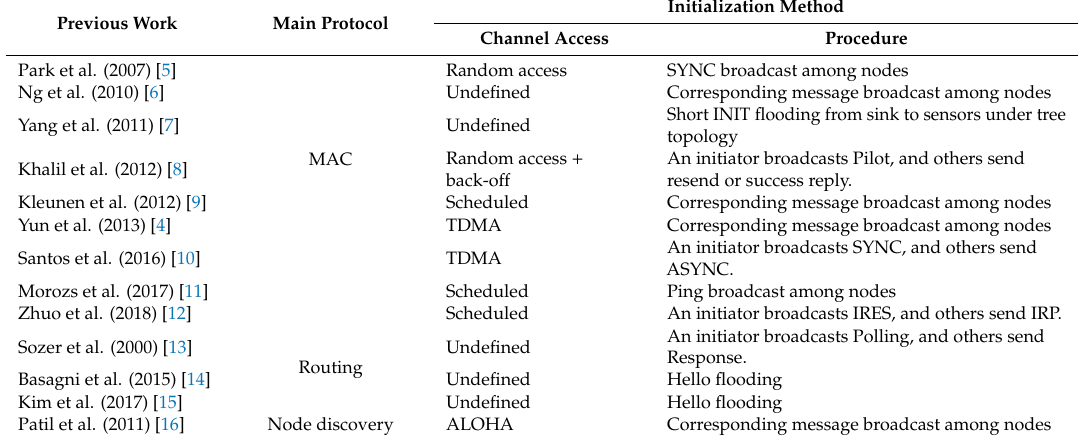
Table 1. Summary of previous works on underwater initialization